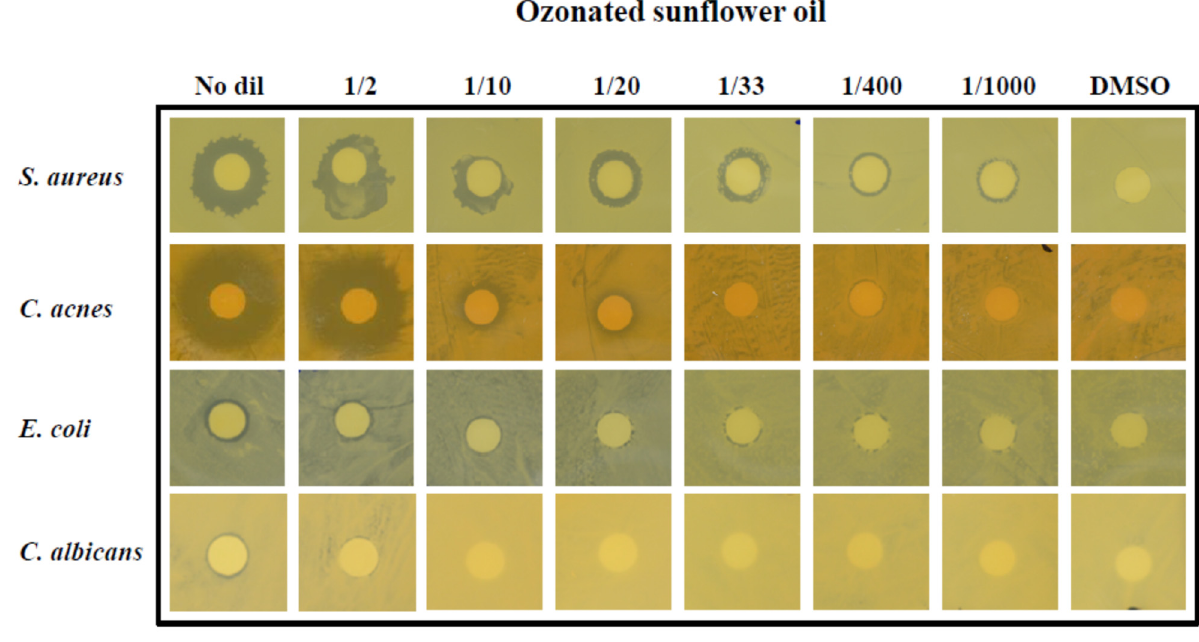
Figure 10. The antibacterial and antifungal effect of ozonated sunflower oil against four test strains by disk diffusion method. No dil, no dilution.